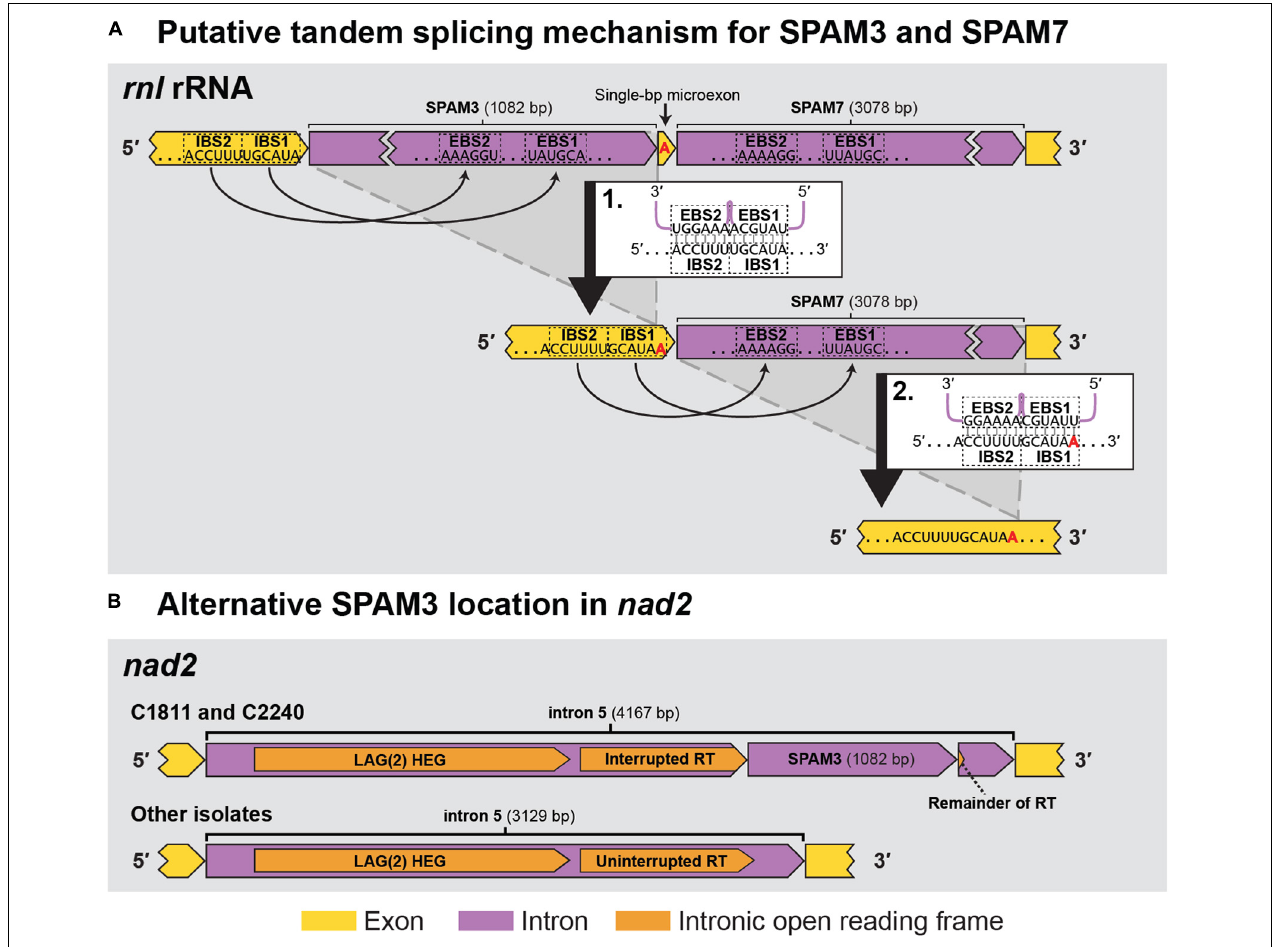
FIGURE 5 | The two observed locations ( rnl rRNA and nad2 ) for SPAM3 within Ceratocystis mitochondrial genomes. (A) Proposed intron splicing mechanism for SPAM3 ( rnl i1) and SPAM7 ( rnl i2) in C. huliohia and C. lukuohia , in which SPAM3 interrupts the IBS1 sequence required for splicing of SPAM7; splicing of SPAM3 (step 1) results in the generation of IBS1 for SPAM7, which permits its subsequent removal (step 2). The single-bp exon is indicated in red. EBS = exon binding site; IBS = intron binding site. (B) Schematic of nad2 i5 in C. fimbriata isolate C1811 and C. polychroma isolate C2240, in which nad2 i5 is a complex group IIA intron that appears to encode within its domain IV a double-motif LAGLIDADG homing endonuclease [LAG(2)] and a reverse transcriptase (RT) interrupted by an identical copy of